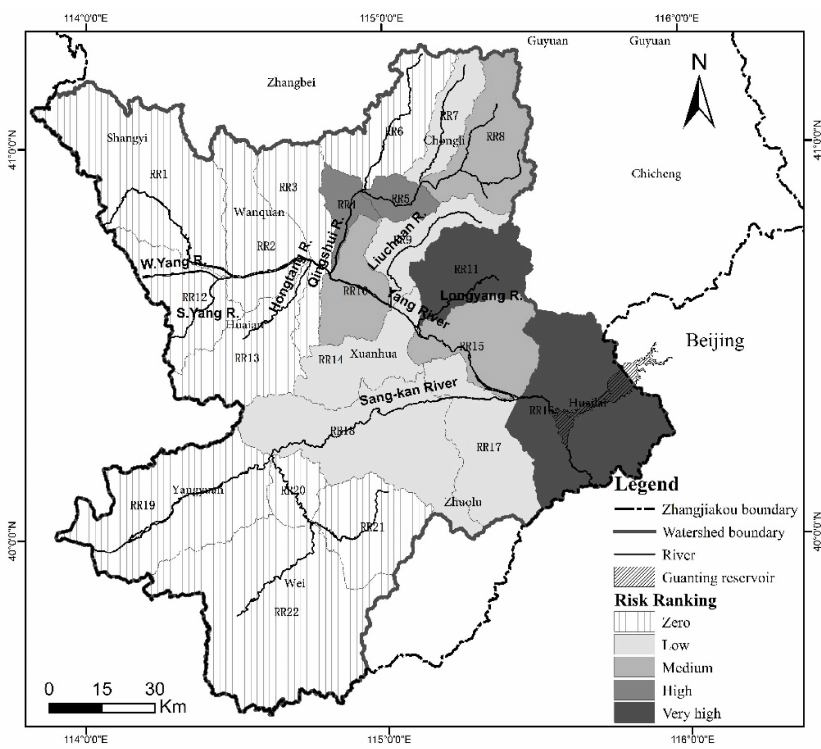
Figure 3. Risk ranking map for sub-watersheds RR1-22 in Guanting Reservoir Watershed within